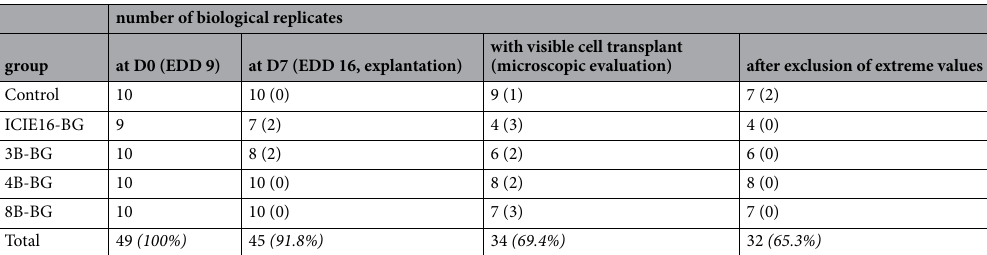
Table 3. Number of biological replicates in the CAM assay at different time points: directly after transplantation (D0), after explantation (D7), with visible cell transplants (microscopic evaluation) and after exclusion of extreme values. Data in brackets describe the individual dropouts for each group and time point. Data in brackets written in italics describe the overall relative rate (in %) of included biological replicates, equivalent to the ‘survival-rate’ at D7 and to the ‘take-rate’ of transplants after microscopic